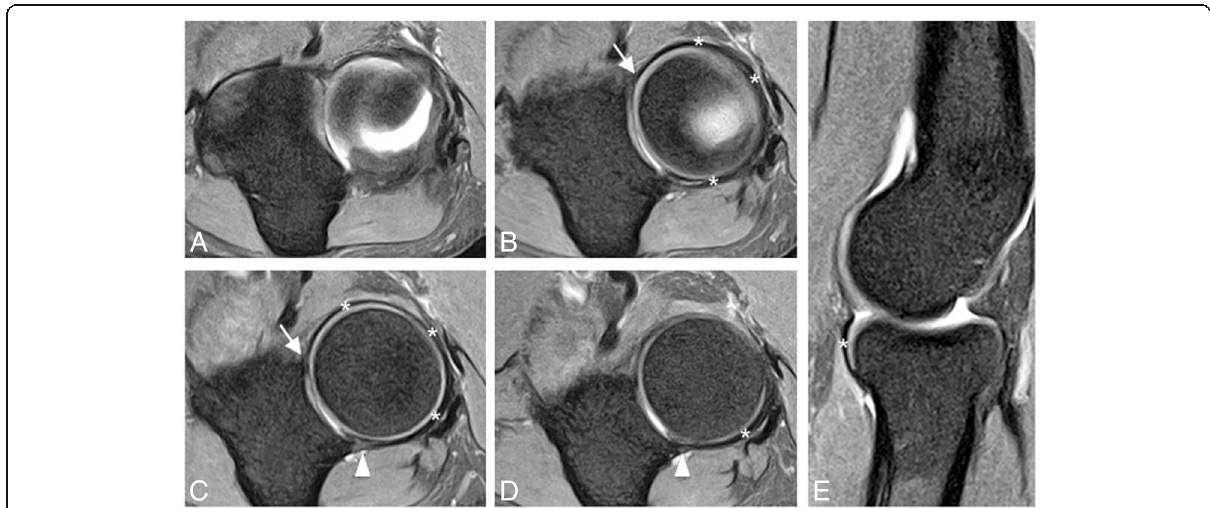
Fig. 8 Axial FS PD-weighted MRI ( a – d ) and sagittal FS PD-weighted MRI ( e ) showing the intact annular ligament (white asterisks). Anterior attachment of the annular ligament (white arrow). The posterior attachment of the annular ligament can be fenestrated (white arrowheads). The annular ligament encircles the periphery of the radial head (white asterisks in b-d )